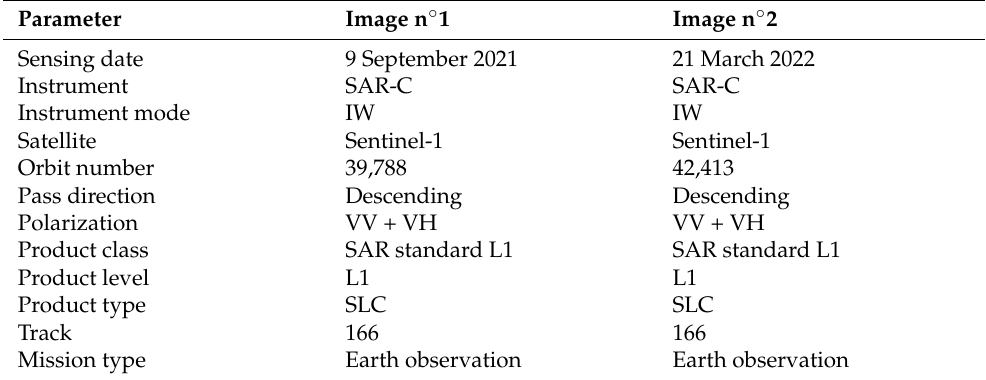
Table 1. Description of the two SAR images